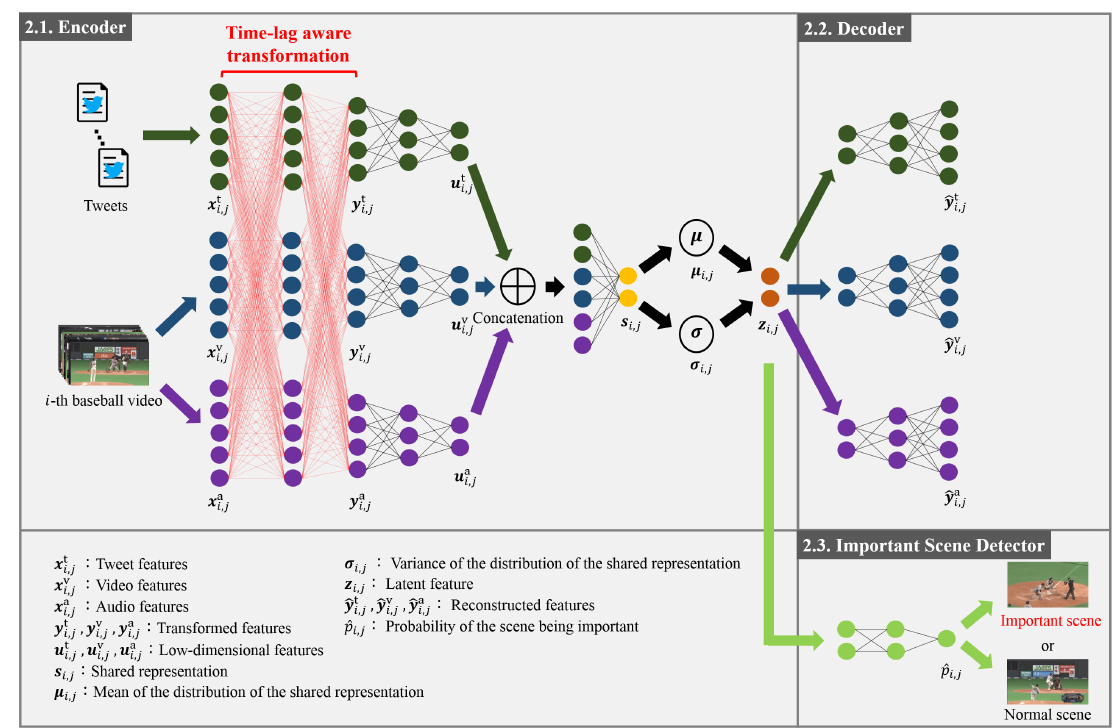
Figure 1. Outline of the time-lag-aware multimodal variational autoencoder (Tl-MVAE). The Tl-MVAE encodes tweet, video, and audio features into latent features based on feature correlations with the consideration of time-lags, as described in Section 2.1. Furthermore, the Tl-MVAE reconstructs the original features from the latent features as described in Section 2.2. Finally, the Tl-MVAE detects important scenes by using the latent features as described in Section